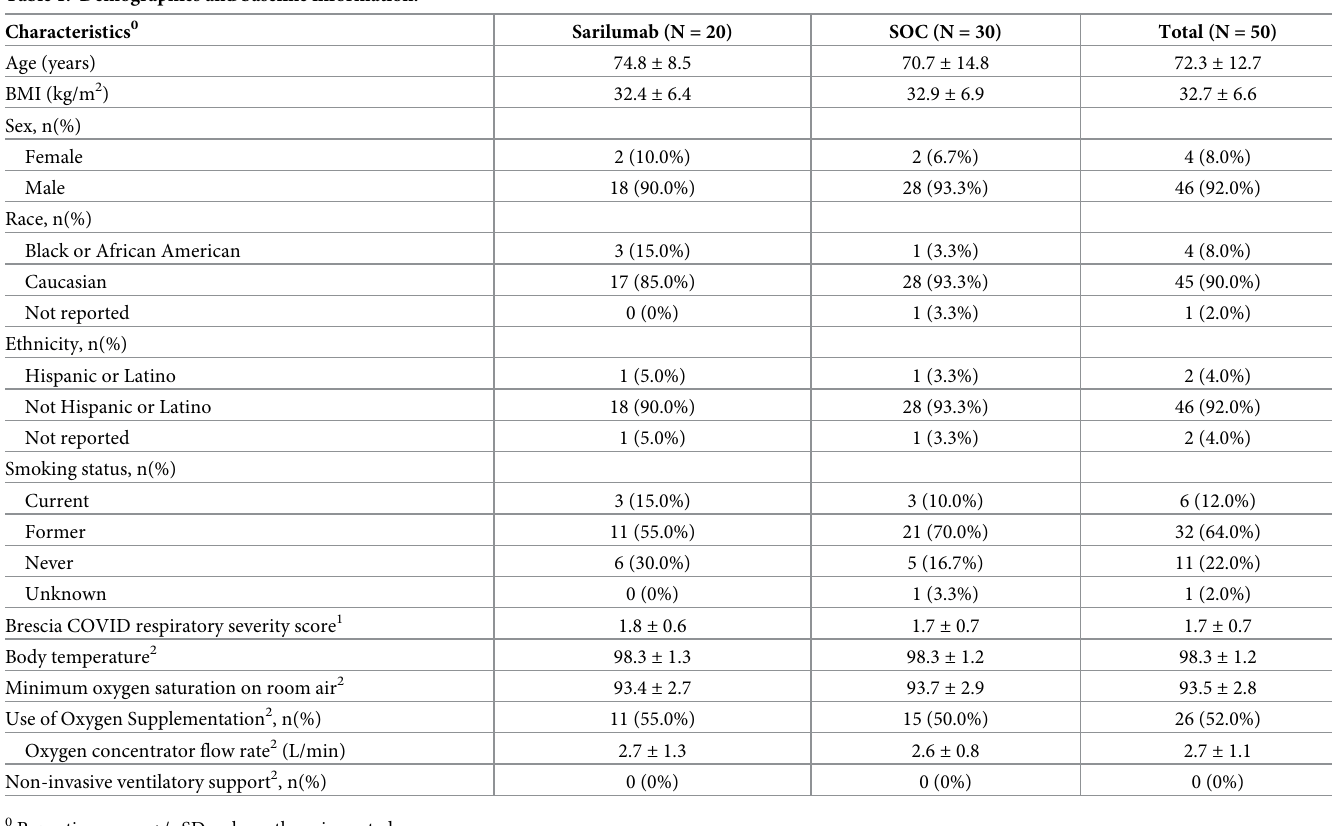
Table 1. Demographics and baseline